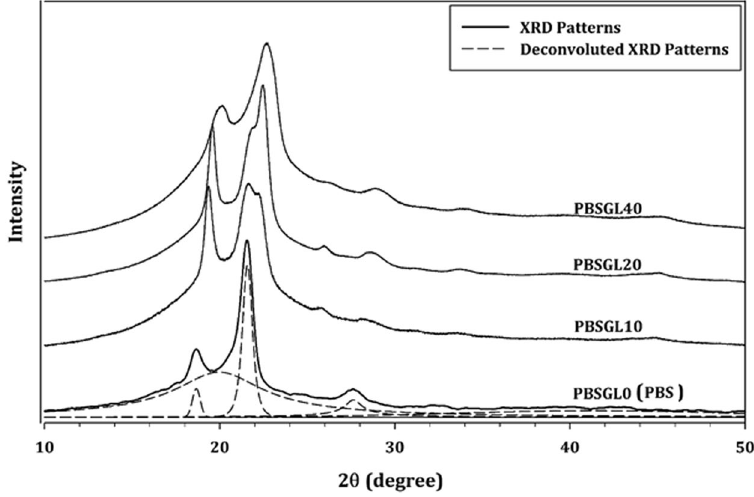
Figure 4. XRD patterns of PBSGL n